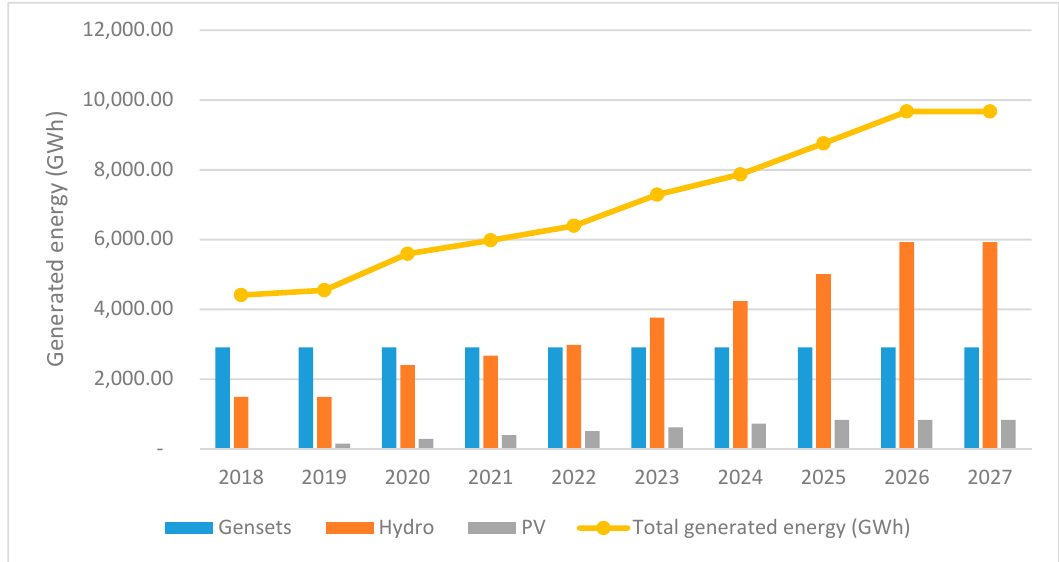
Figure 12. Forecast of generated electrical energy with gensets, hydro and PV.